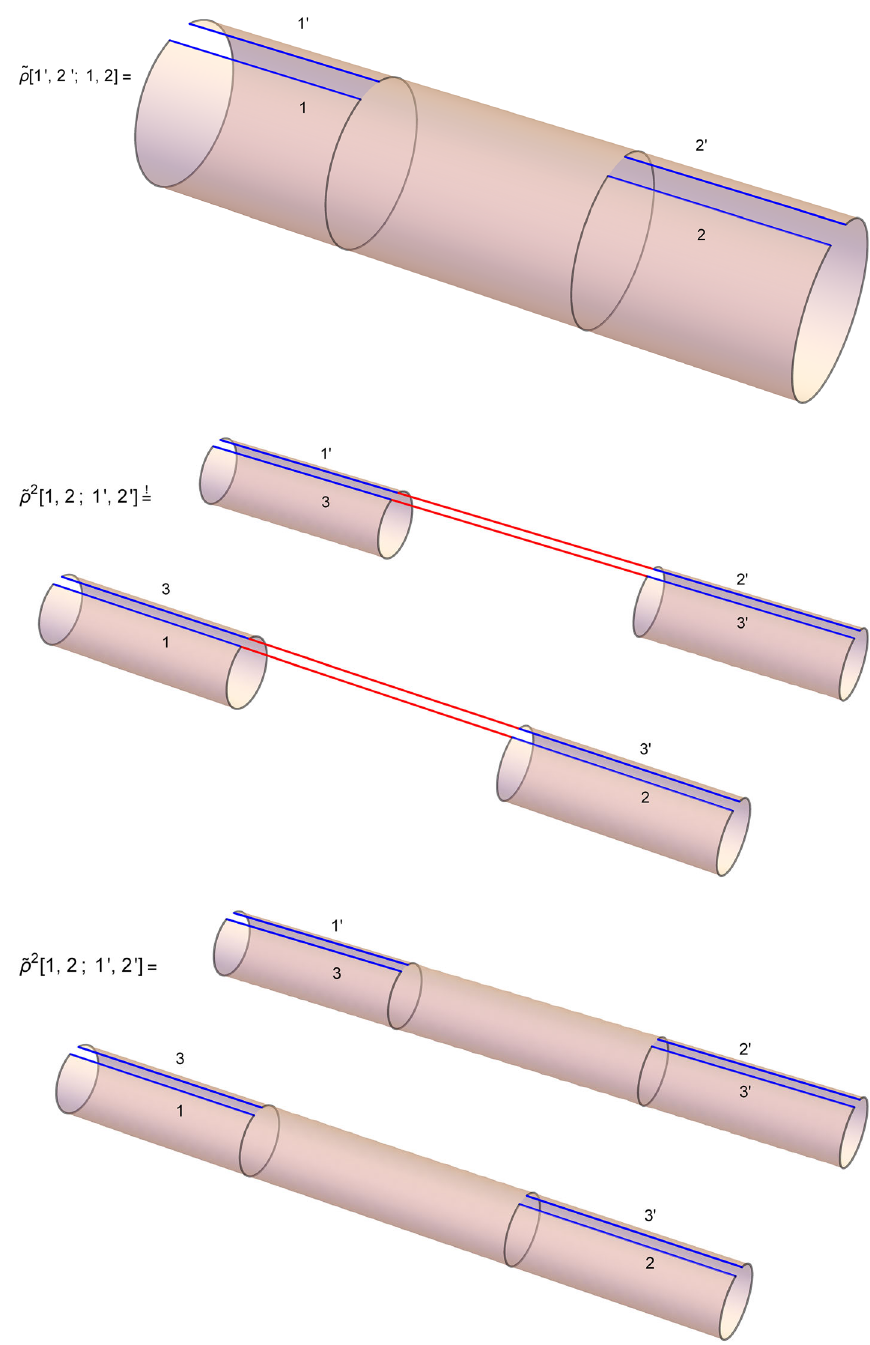
representation of the reduced density matrix